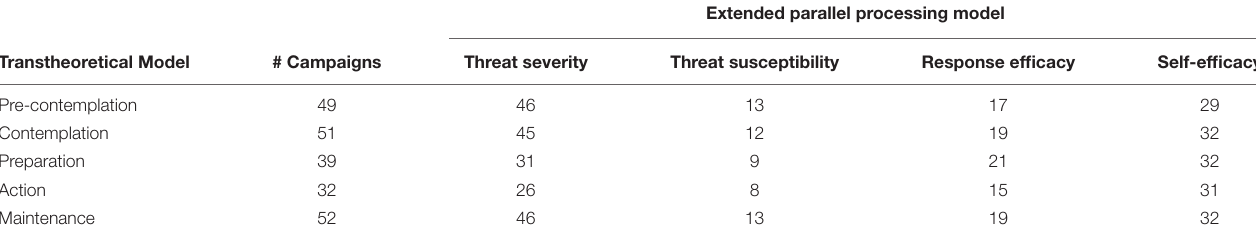
TABLE 2 | Extended Parallel Processing Model and Transtheoretical Model coding